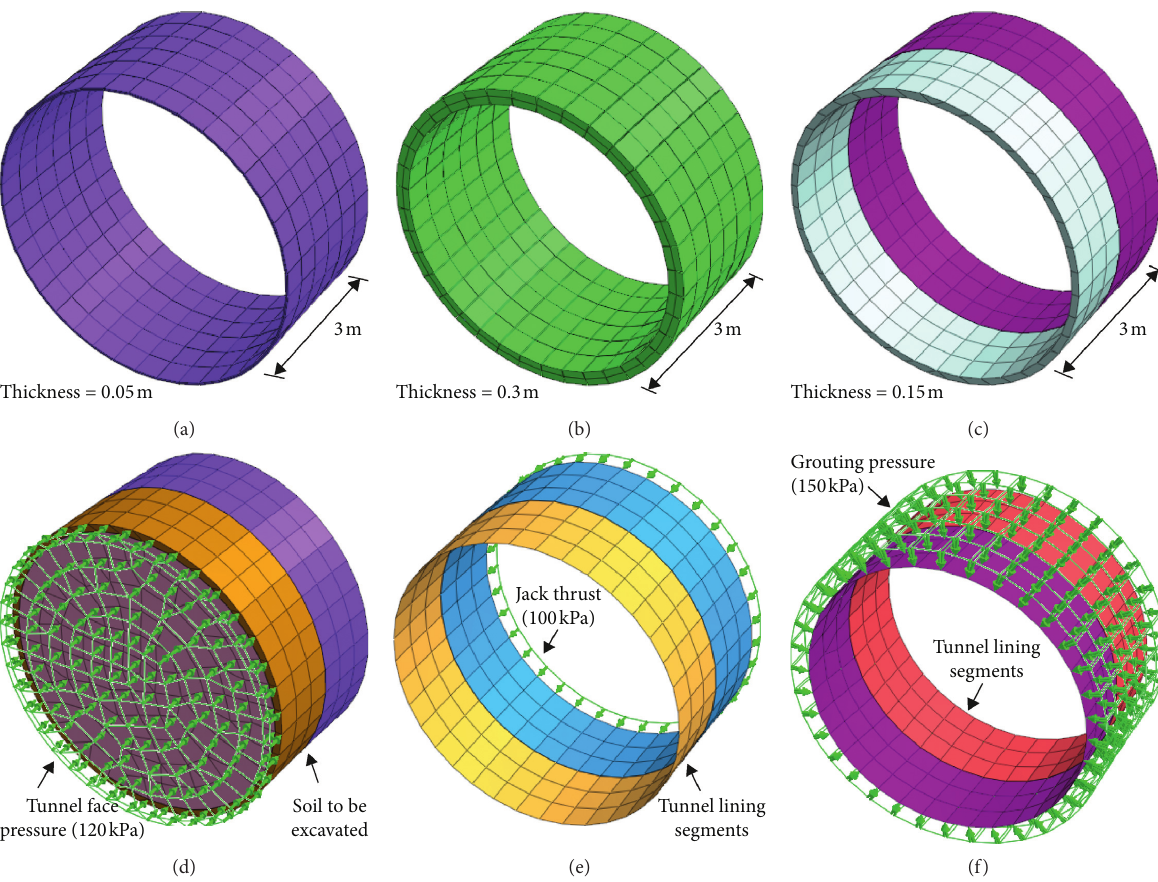
Figure 6: Tunnelling sequence simulation in a tunnelling step: (a) TBM shell, (b) tunnel lining segments, (c) grout layer, (d) tunnel face pressure, (e) Jack thrust, and (f) grouting pressure.